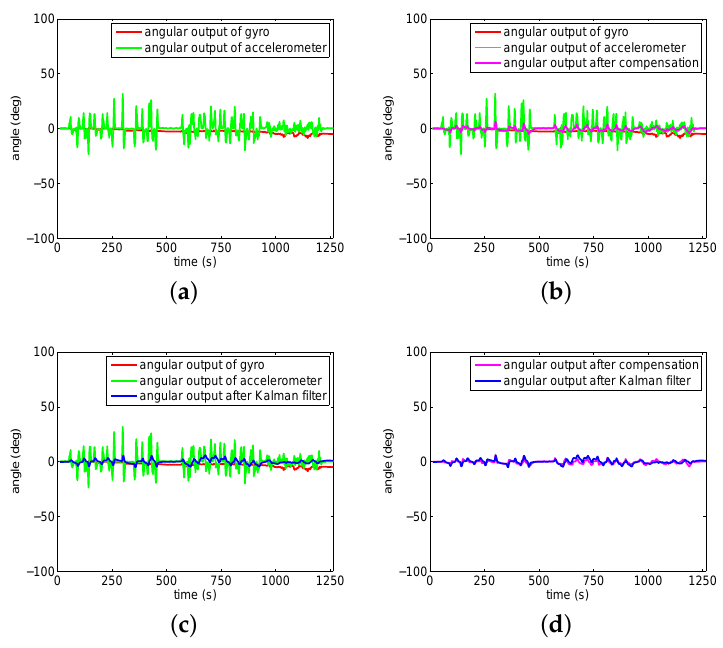
Figure 10. Experiment 3 (Red line is angular output of gyro. Green line is angular output of accelerometer. Carmine line is angular output after compensation. Blue line is angular output after Kalman filter.). ( a ) Angular outputs of gyro/accelerometer; ( b ) Applying the proposed compensation method; ( c ) Applying Kalman filtering method; ( d ) Comparison of two